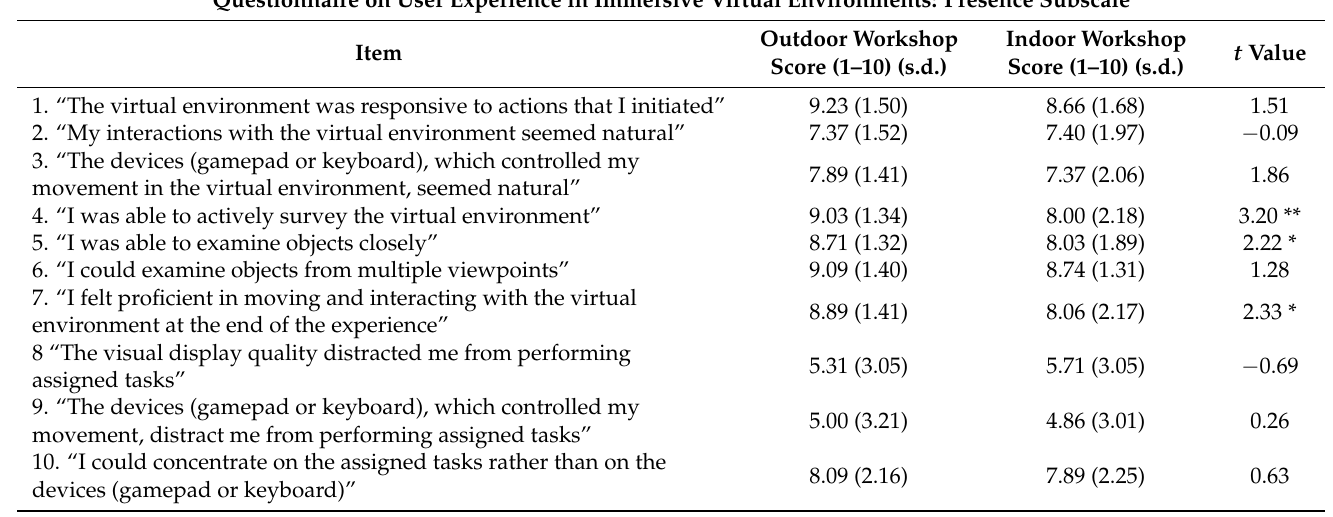
Table 3. Questionnaire on User eXperience in Immersive Virtual Environments: presence subscale.